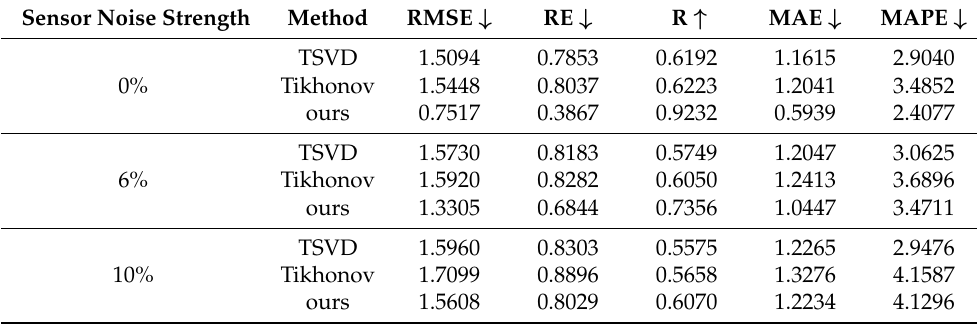
Table 10. Quantitative comparisons on different strengths of additional sensor